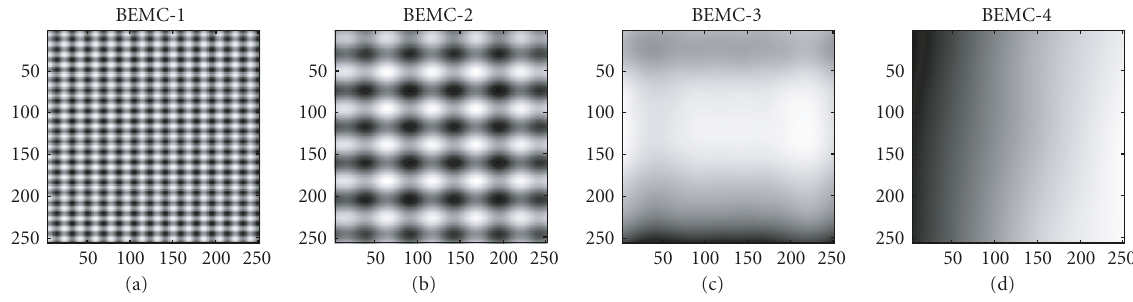
Figure 17: BEMCs of the STI obtained by BEMD with RBF-TPS (MNAI =